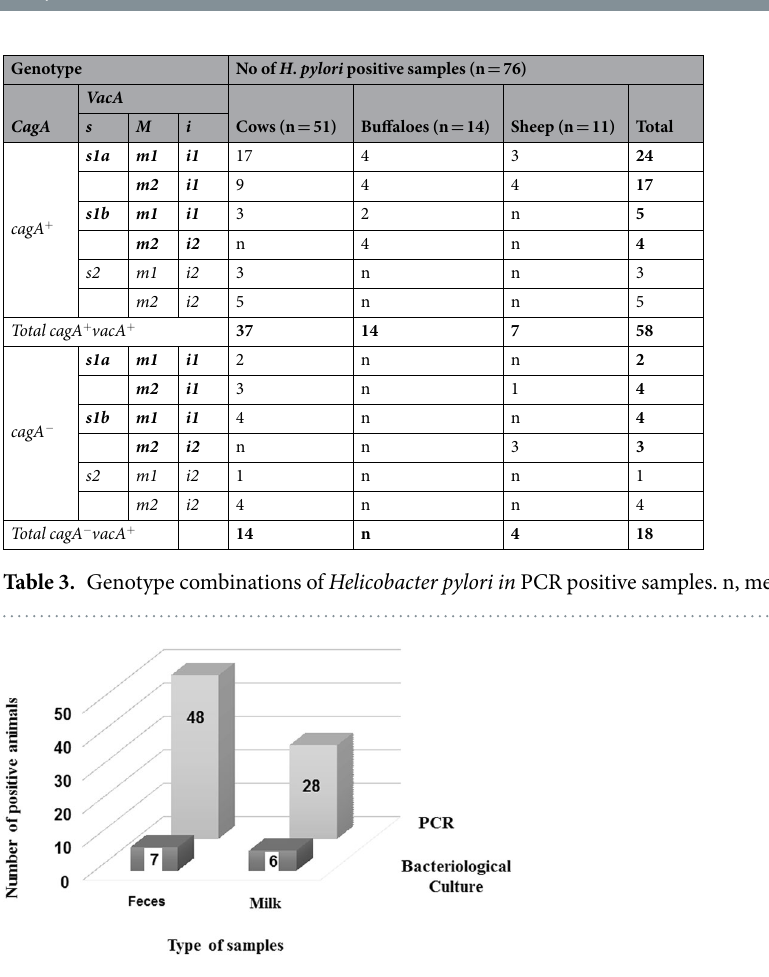
Figure 2. Number of PCR positive samples that contained the spiral viable culturable form of Helicobacter pylori as determined by bacteriological culture and identification. Milk and fecal samples from the three species of animals that were positive using PCR were subjected to bacteriological culture and biochemical identification. The results are shown as total numbers of milk samples (Milk) and fecal samples (Feces) that were tested positive in PCR (PCR) and numbers of PCR positive samples that showed positive colonies of H . pylori (Bacteriological